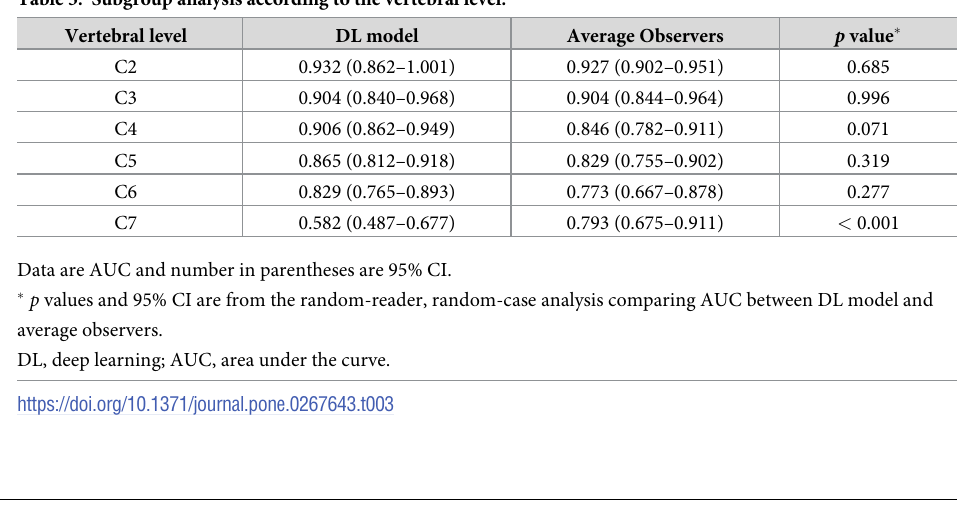
Table 3. Subgroup analysis according to the vertebral